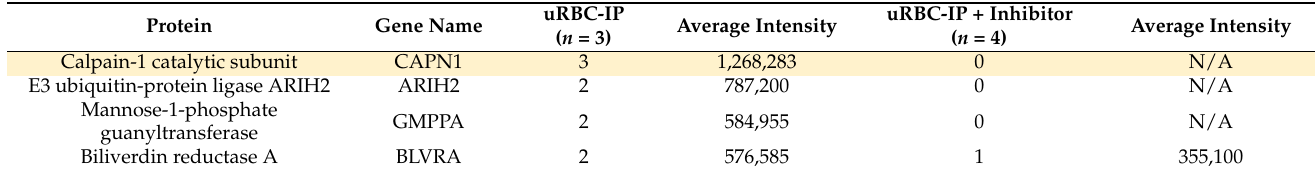
Table 2. BCL-x L binding partners identified in uRBCs. Mass spectrometry analysis of BCL-x L immunoprecipitates from uRBCs with and without the BCL-x L inhibitor WEHI-539 over three and four independent biological replicates, respectively ( n = 3–4). The number of replicates in which the protein was identified is indicated, along with its relative average intensity.